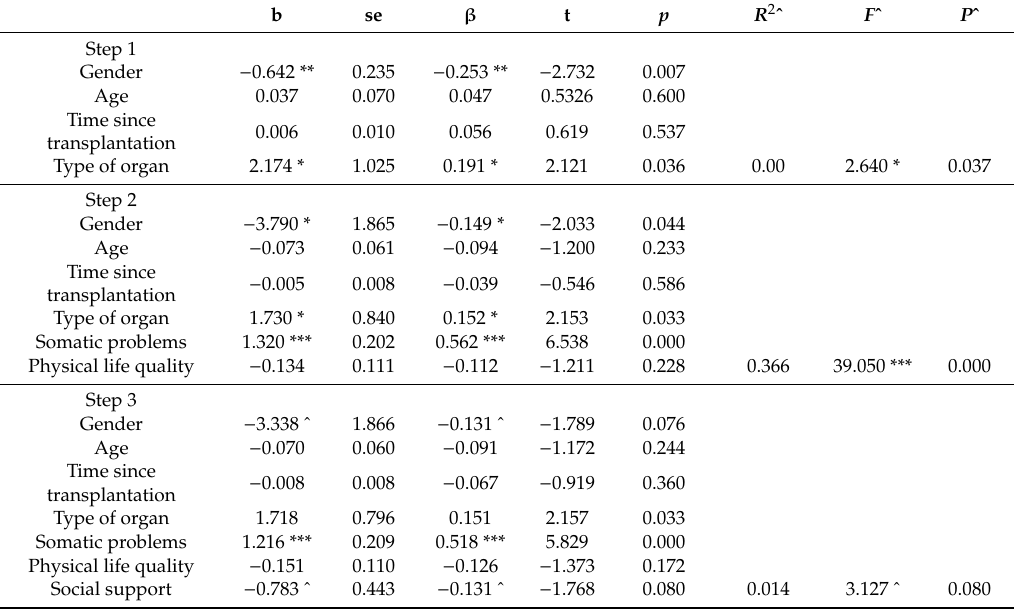
Table 3. Hierarchical regression to predict AD among patients.